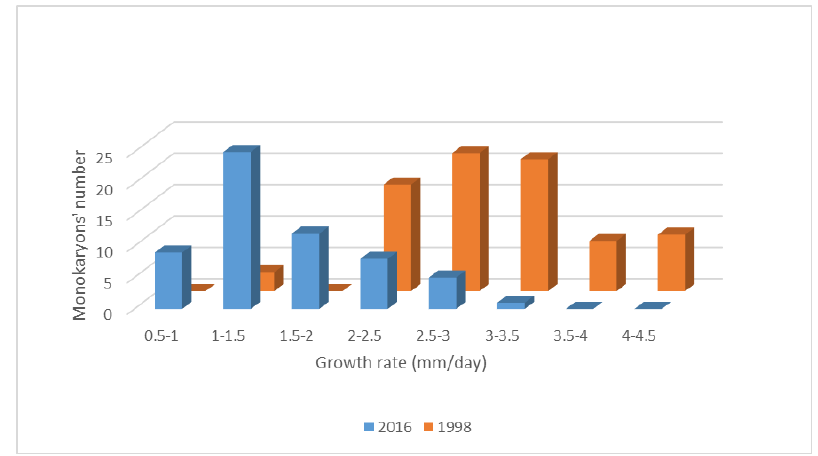
Figure 1. Comparison of the growth rates of two monokaryotic progenies obtained from DkN001 in 1998 (80 monokaryons, orange) and 2016 (60 monokaryons, blue). Growth rate data were grouped in intervals and measured in mm/day as described in Materials and Methods.